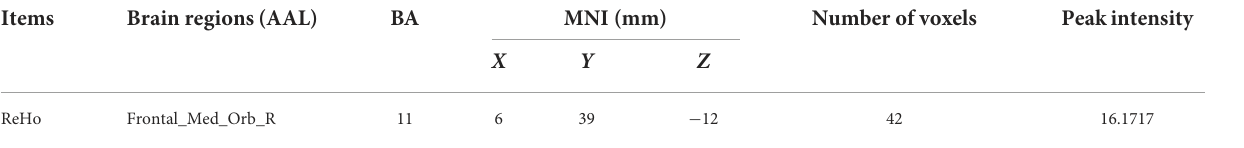
TABLE 2 Brain changes with Group × stimulation interaction. Items